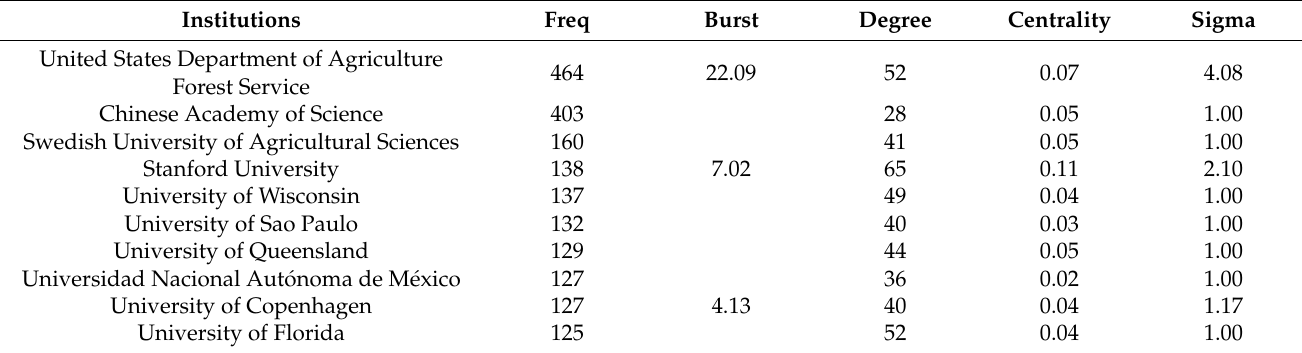
Table 3. Top 10 institutions in terms of the number of publications on FES-related